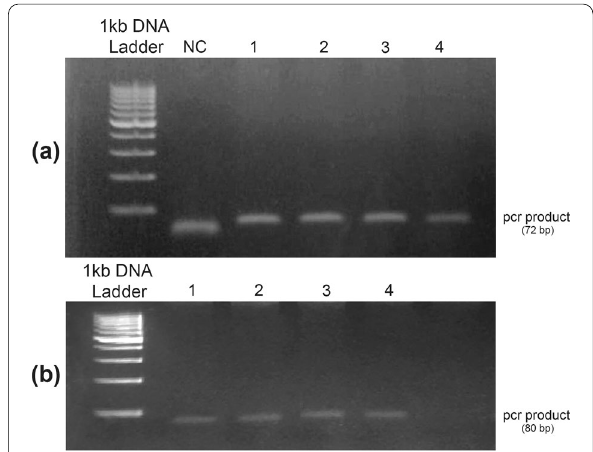
Fig. 1 Agarose gel electrophoresis for BRCA1 185delAG & BRCA1 5382insC founder mutations. a Agarose gel electrophoresis (2%) for BRCA1 5382insC in which the product band is at 72 bp. The first lane: size marker (1 Kb ladder), The second lane: negative control; the band is a primer dimer band. Lanes 3, 4, 5 and 6: four FOC patients. b Agarose gel electrophoresis (2%) for BRCA1 185delAG in which the product band is at 80 bp in FOC